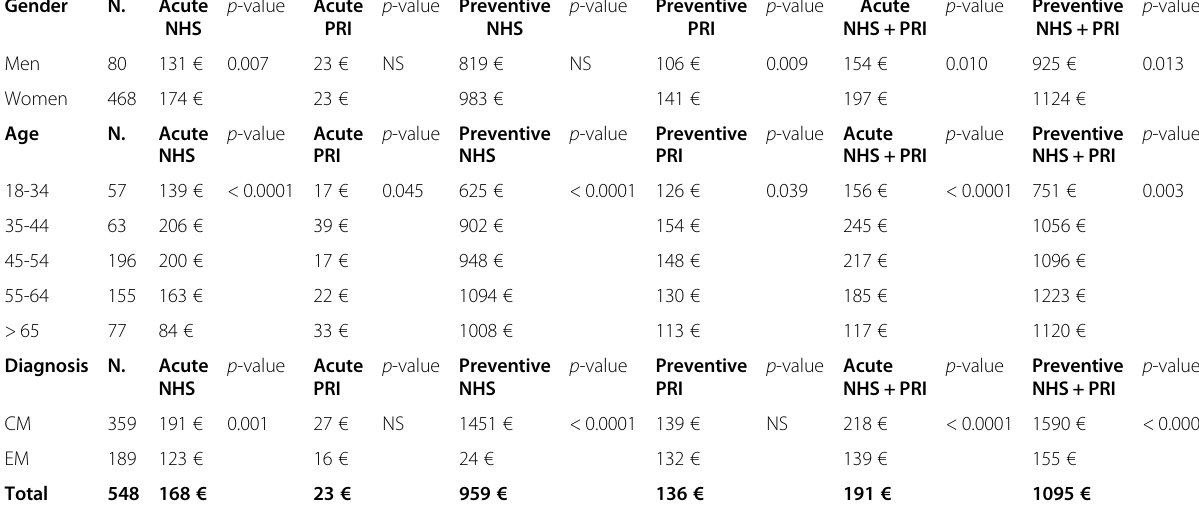
Table 6 Annual cost of medications by gender, age and migraine status Gender N.